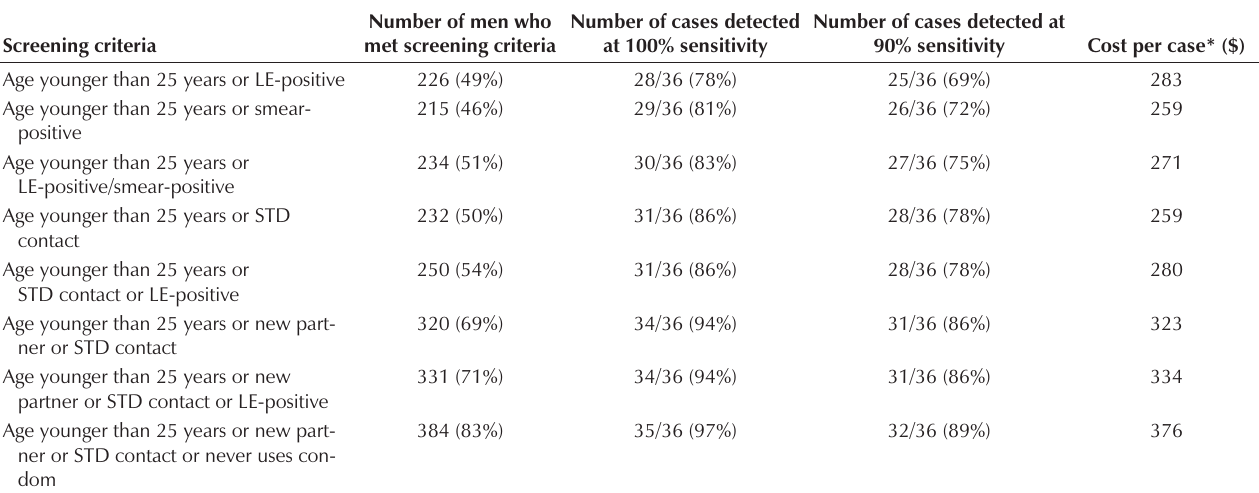
TABLE 3 Cost of different screening strategies for men aged younger than 25 years attending a sexually transmitted disease (STD) clinic Screening criteria